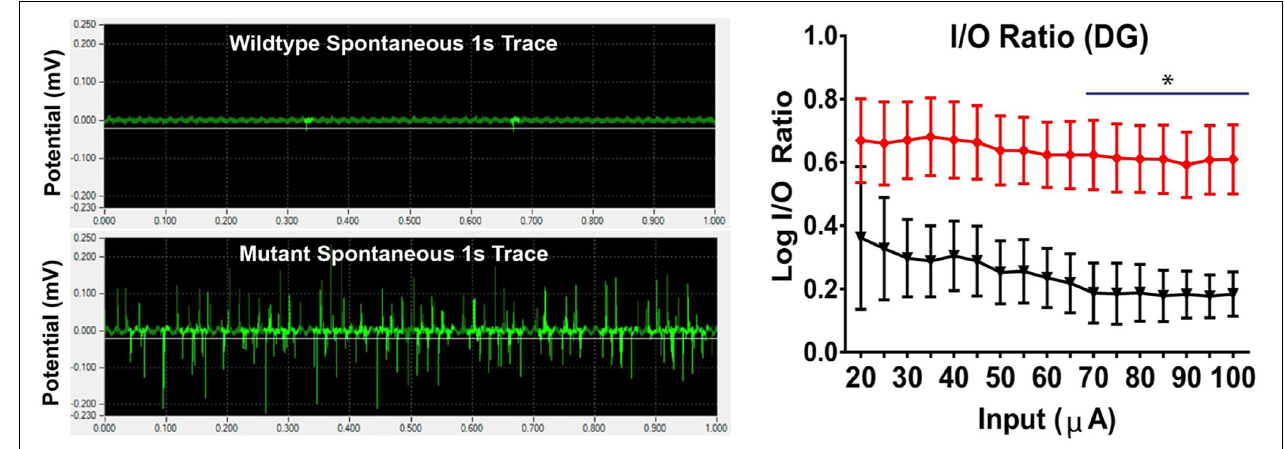
FIGURE 8 | Seizure activity resulting from STGD3 deletion. Left: Spontaneous bursting activity in hippocampal slices from S + Elovl4 mut / mut mice with knock-in of the 5 bp STGD3 mutation and skin-specific rescue of wildtype (WT) ELOVL4 function to prevent perinatal lethality, and S + Elovl4 wt / wt control mice expressing the WT ELOVL4 gene under baseline conditions. Representative traces of field potentials from postnatal day 19 S + Elovl4 wt / wt (upper trace) and S + Elovl4 mut / mut mice (lower trace) . Each trace represents the first 1 s of a single channel chosen from a 10 min recording taken using a 64 channel multi-electrode array. The S + Elovl4 mut / mut slice shows a dramatic increase in spontaneous neuronal activity compared to WT littermates. Right: Stepwise increased stimulations to perforant path synapses in dentate gyrus (DG) revealed a markedly enhanced input/output (I/O) ratio indicating a boost in synaptic strength in the main input pathway from the entorhinal cortex of S + Elovl4 mut / mut mice (red) compared to S + Elovl4 wt / wt control mice (statistics: two-way RM ANOVA, ∗ p < 0.05 from 70 to 100 µ A). Reproduced from Hopiavuori et al. (2018) with the permission under the Creative Commons Attribution 4.0 International License (link to the Creative Commons license; http://creativecommons.org/licenses/by/4.0/).